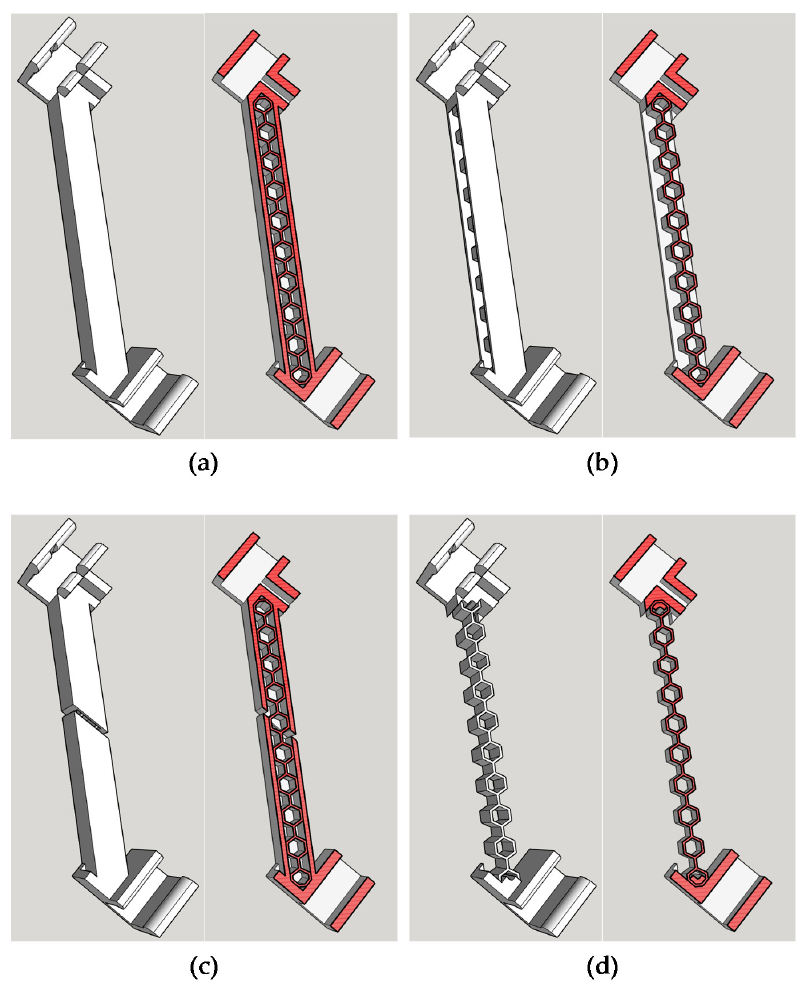
Figure 2. The designs of the composite bracing systems. ( a ) Honeycomb infill bracing; ( b ) Honeycomb sandwich bracing; ( c ) Damaged honeycomb infill bracing; ( d ) Honeycomb bracing.